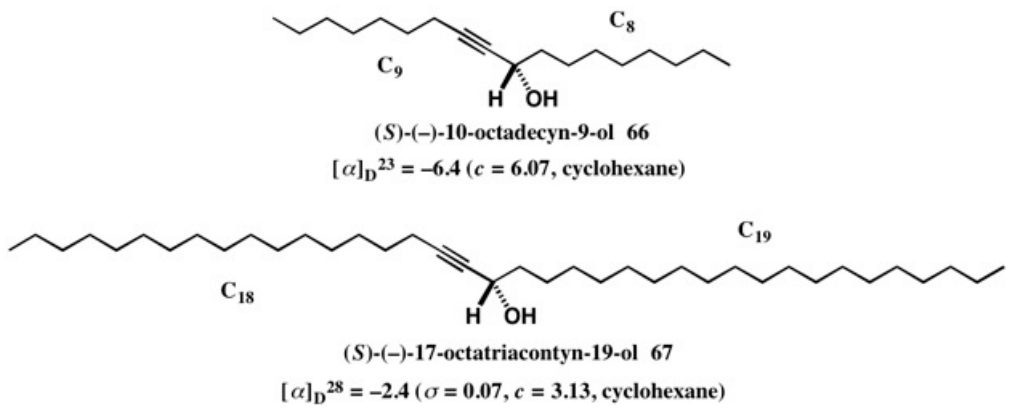
Figure 46. Enantiopure acetylene alcohols with established ACs, which were prepared by the M α NP acid method.